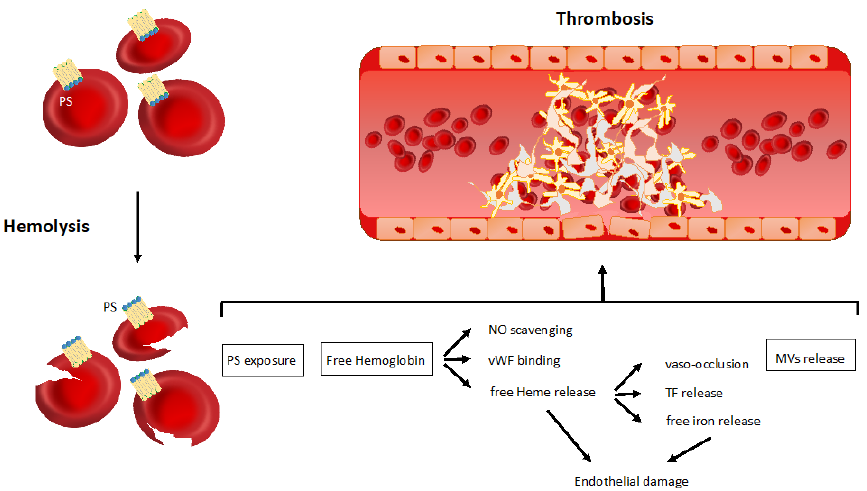
Figure 1. Non-immune related mechanisms of thrombosis in hemolytic anemia. The main pathophysiological mechanisms linking hemolysis to thrombosis are represented in the figure—phosphatidylserine exposure on the red blood cell surface; free hemoglobin and heme release from damaged red blood cells; red blood cells-derived microvesicle shedding. PS, phosphatidylserine; NO, nitric oxide; vWF, von Willebrand factor; TF, tissue factor; MVs, microvesicles.